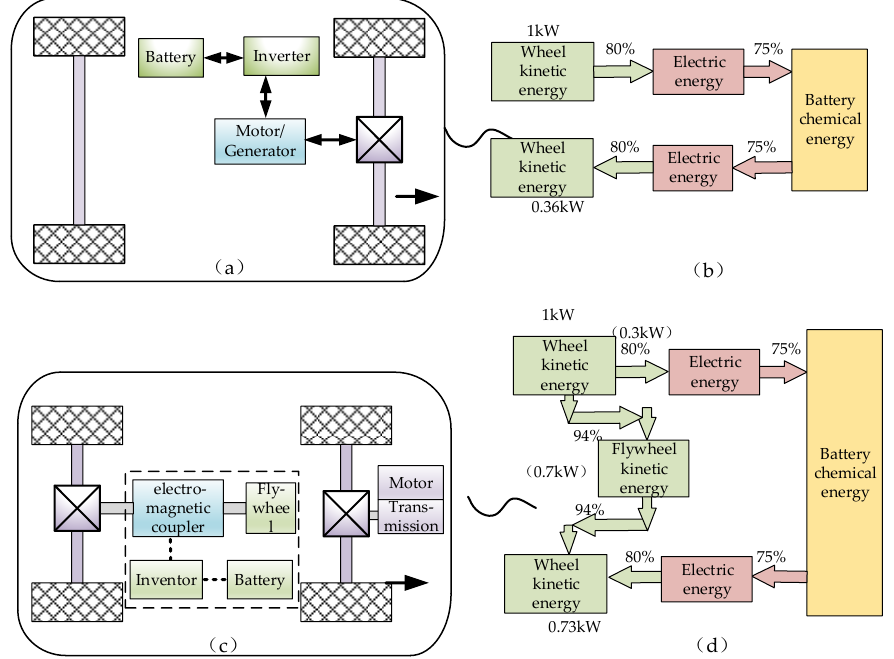
Figure 3. Wheel–wheel energy conversion efficiency: ( a ) BEV technical scheme; ( b ) BEV electric powertrain energy conversion efficiency; ( c ) ECFESS technical scheme; ( d ) ECFESS energy conver- sion efficiency.